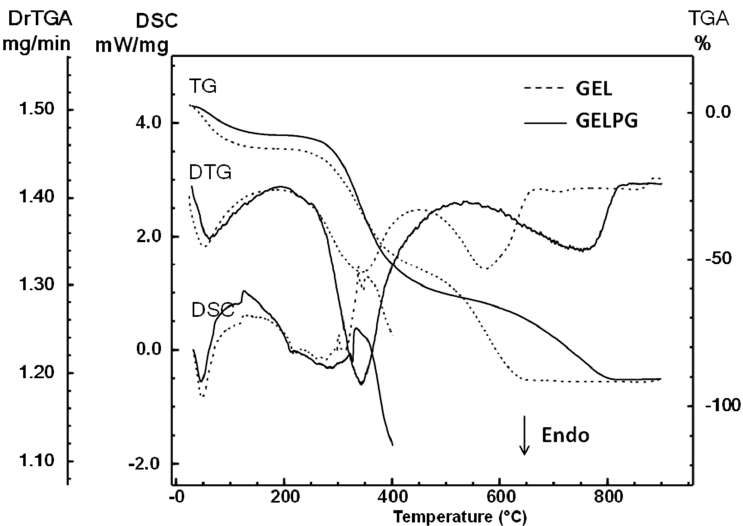
Figure 2. Differential scanning calorimetry (DSC), thermogravimetric (TGA), and derivative thermogravimetric (DrTGA) curves of the GEL (gelatin membrane) and GELPG (gelatin membrane containing aqueous extract of P. granatum ) .